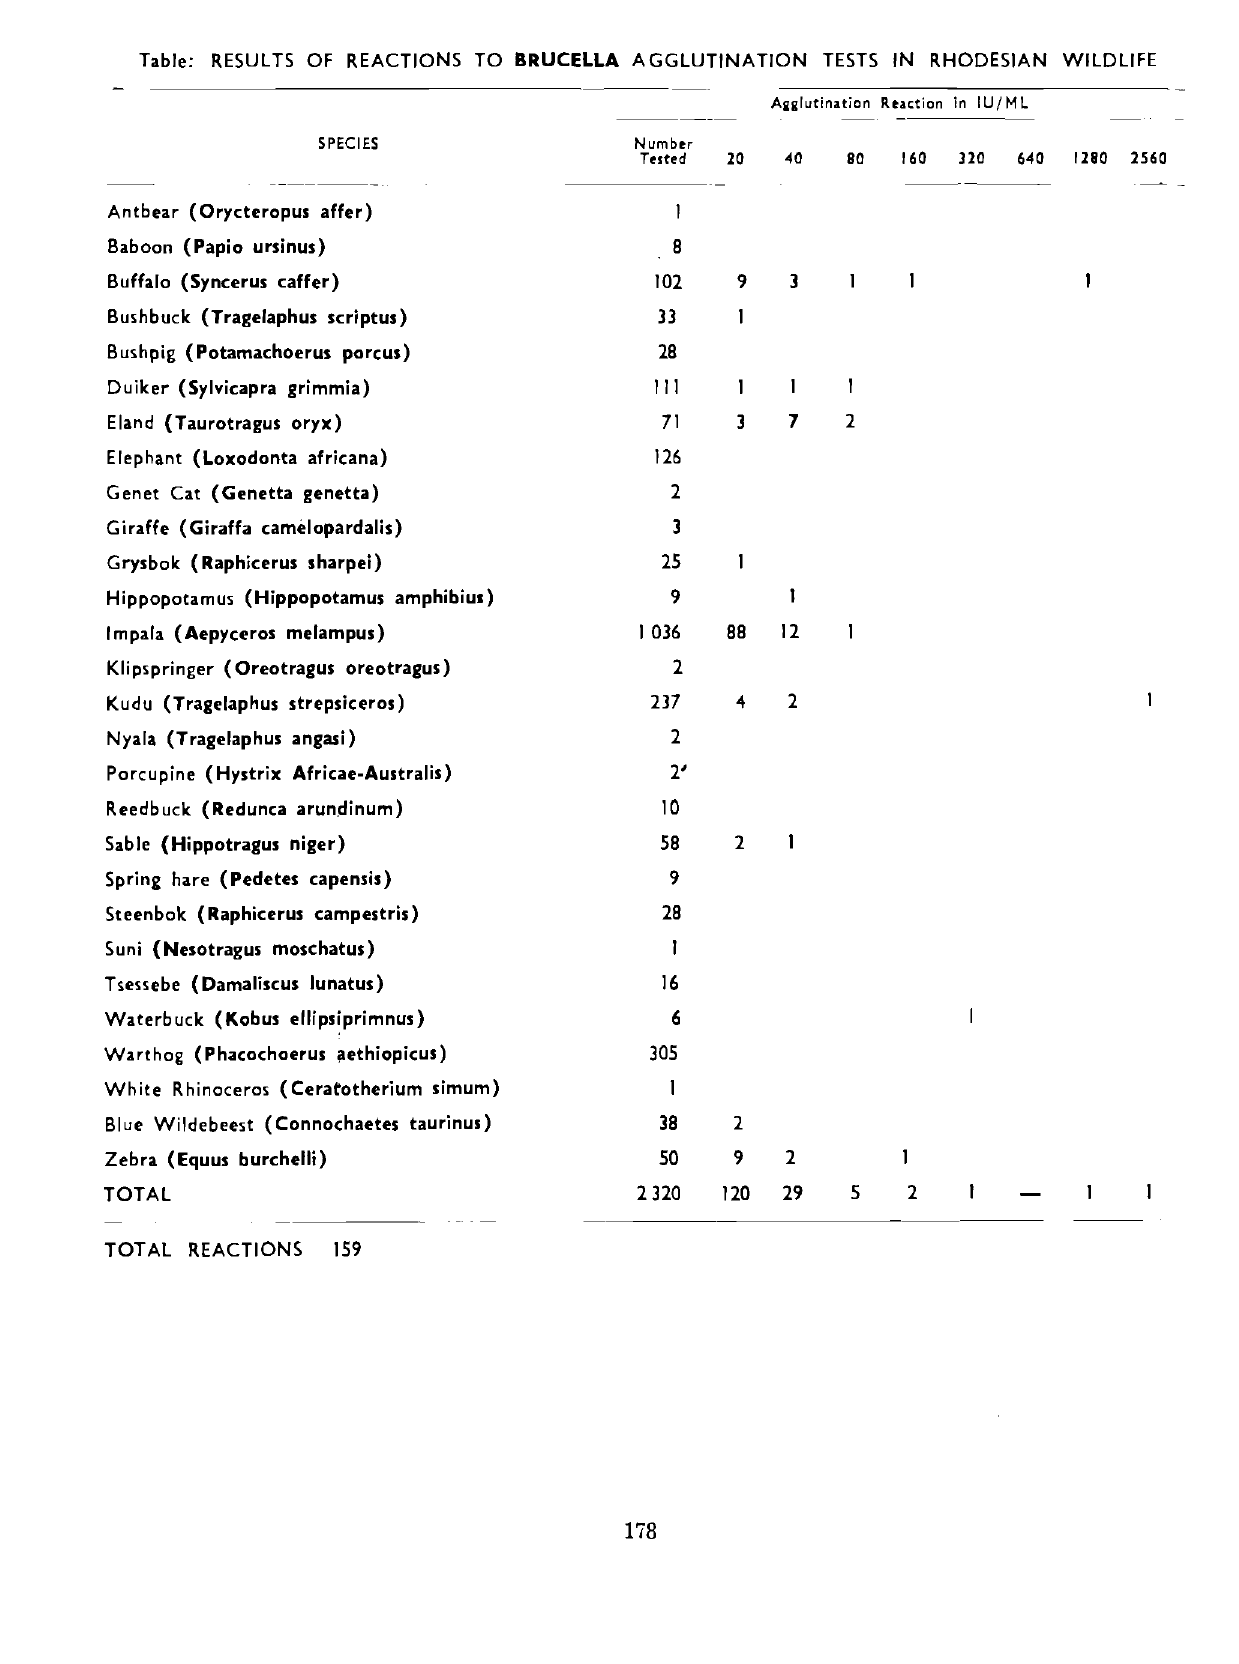
Table: RESULTS OF REACTIONS TO BRUCELLA AGGLUTINATION TESTS IN RHODESIAN